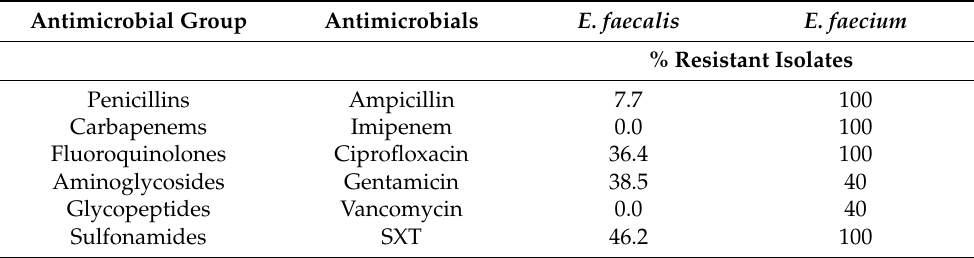
Table 7. Antimicrobial resistance of Gram-positive bacteria isolated from urine culture of hospitalized patients from January to June